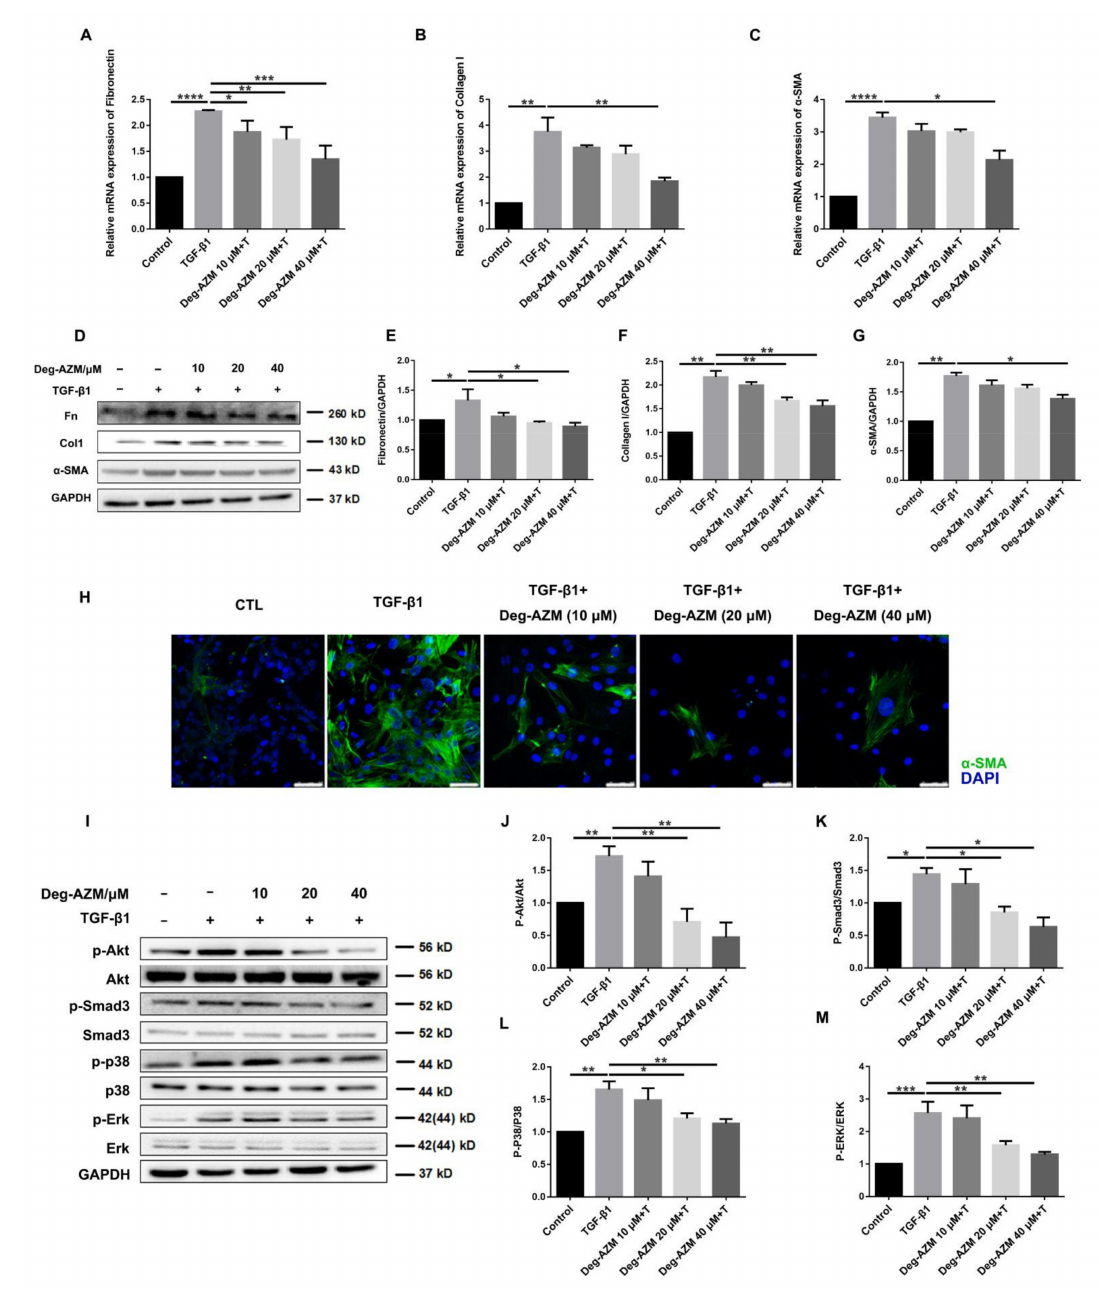
Figure 5. Deglycosylated azithromycin attenuates TGF- β 1-induced myofibroblast activation. ( A – C ) NIH-3T3 cells were treated with TGF- β 1 (5 ng/mL) and deglycosylated azithromycin (10, 20 and 40 µ M) for 24 h. Fn, Col1 and α -SMA were analyzed by real-time PCR in NIH-3T3 cells, ( n = 3 per group). ( D ) NIH-3T3 cells were treated with TGF- β 1 (5 ng/mL) and deglycosylated azithromycin (10, 20 and 40 µ M) for 24 h. NIH-3T3 cells were extracted for Western blot analysis of Fn, Col1 and α -SMA. ( E – G ) Densitometric analysis of Fn, Col1 and α -SMA, using GAPDH as the internal reference. ( H ) Immunofluorescence staining of α -SMA was performed on NIH-3T3 cells treated with/without TGF- β 1 (5 ng/mL) and/or deglycosylated azithromycin. (10, 20 and 40 µ M) for 24 h. Scale bar = 20 µ m. ( I ) NIH-3T3 cells were treated with TGF- β 1 (5 ng/mL) for 30 min and extracted for Western blot analysis of p-Akt, p-Smad3, p-p38 and p-Erk1/2 expression. ( J – M ) Densitometric analysis of p-Akt, p-Smad3, p-p38 and p-Erk1/2 normalized to Akt, Smad3, p38 and Erk1/2 levels. Data are presented as the means ± SD ( n = 3). Comparisons between groups were achieved using one-way analysis of variance (ANOVA). * p < 0.05, ** p < 0.01, *** p < 0.001, **** p <